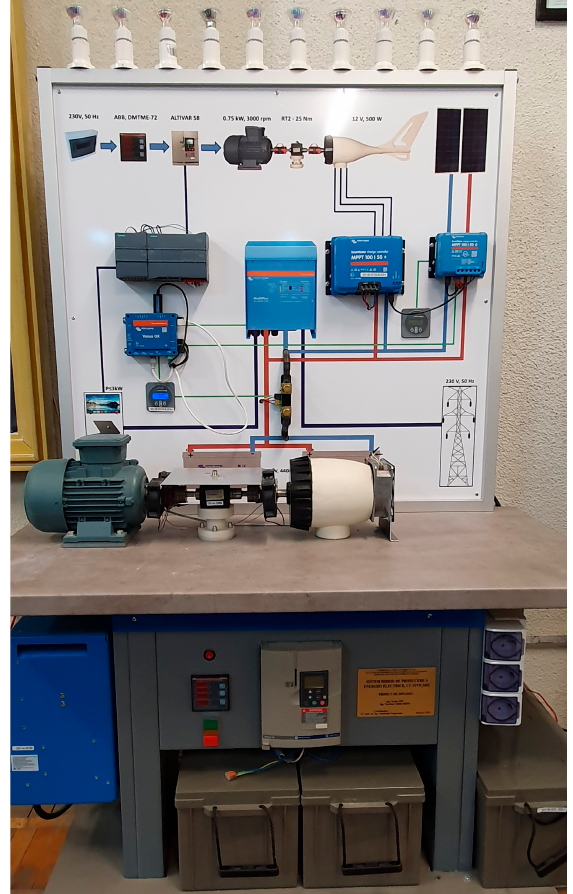
Figure 1. HRES experimental stand and its main components.